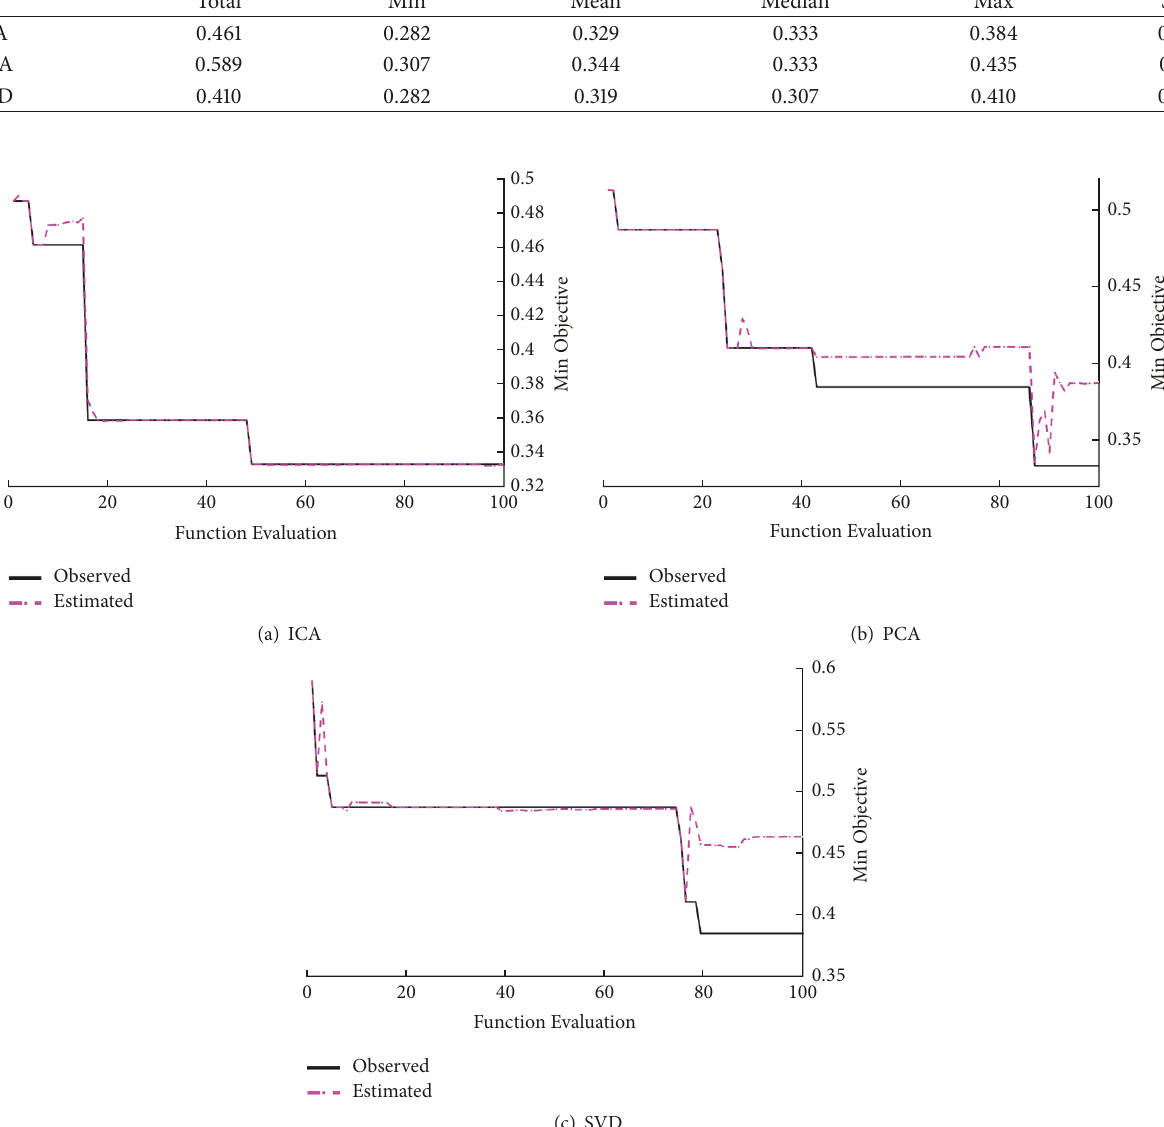
evaluations for ICA, the estimated error rate did not match the observed error rate. However, it reached the minimum estimated error of 0.282 as presented in Table 4. On the other hand, the estimate of the true rate exactly matched the observed error rate employing SVD data reduction scheme and reached the minimum of 0.282